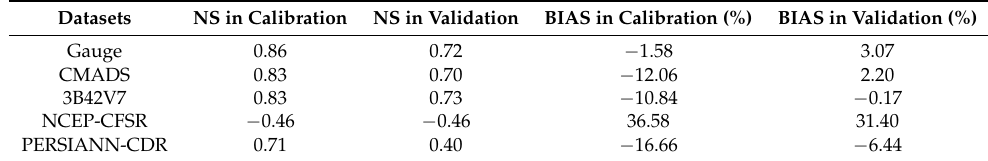
Table 5. NS coefficient and BIAS of daily simulated streamflow.